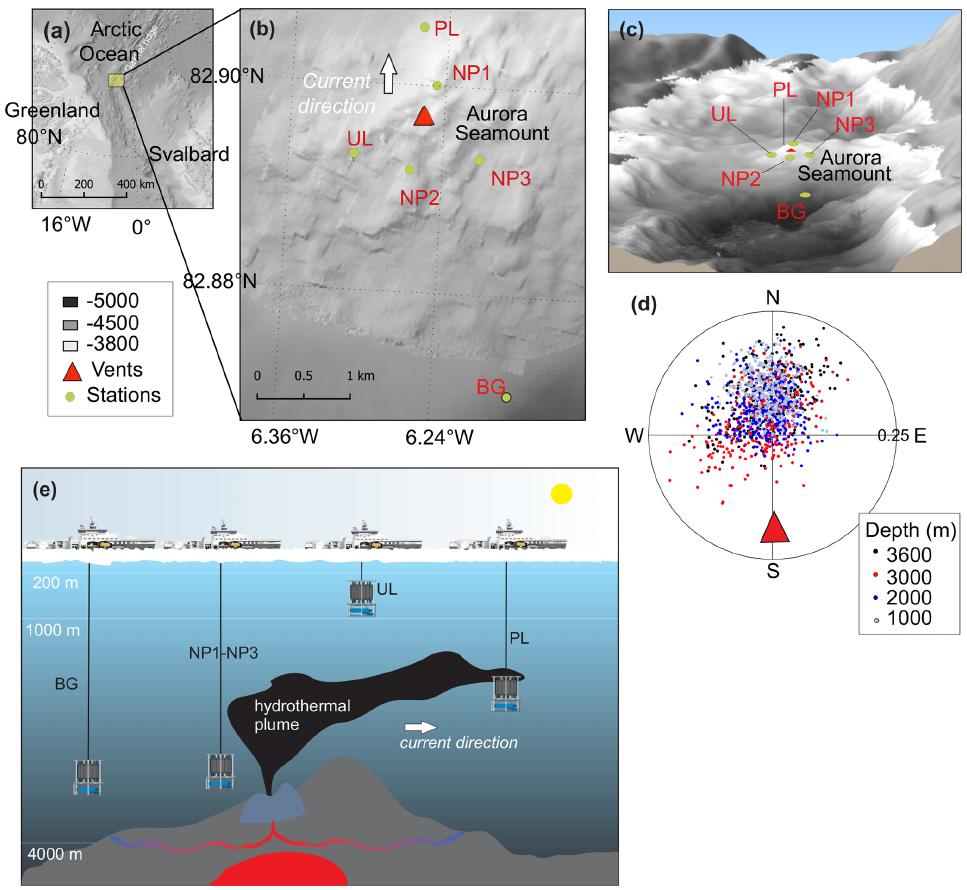
Figure 1. (a) Study site in the Arctic Ocean. (b, c) Close-up of the study site showing the locations of the background station (BG), plume layer station (PL), non-plume stations (NP1 to NP3) and upper layer station (UL) on a bathymetric map (IBCAO; Jakobsson et al., 2008). (d) Direction and the current velocity obtained from the LADCP (lowered acoustic Doppler current profiler) at the PL station where each point represents an average of a depth bin calculated from east and north velocity components. (e) The graphical representation of station locations with respect to the dispersion of the hydrothermal plume, current direction and the oceanic layers. Table 1. Sampling stations, positions, water depth and measured parameters at corresponding sampling depths for methane, δ 13 C-CH 4 , dissolved organic matter (DOM) composition and nutrients (see text for